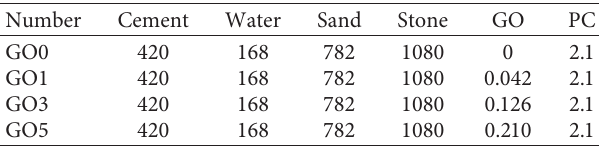
Table 3: Mixing proportions of GO concrete (kg/m 3